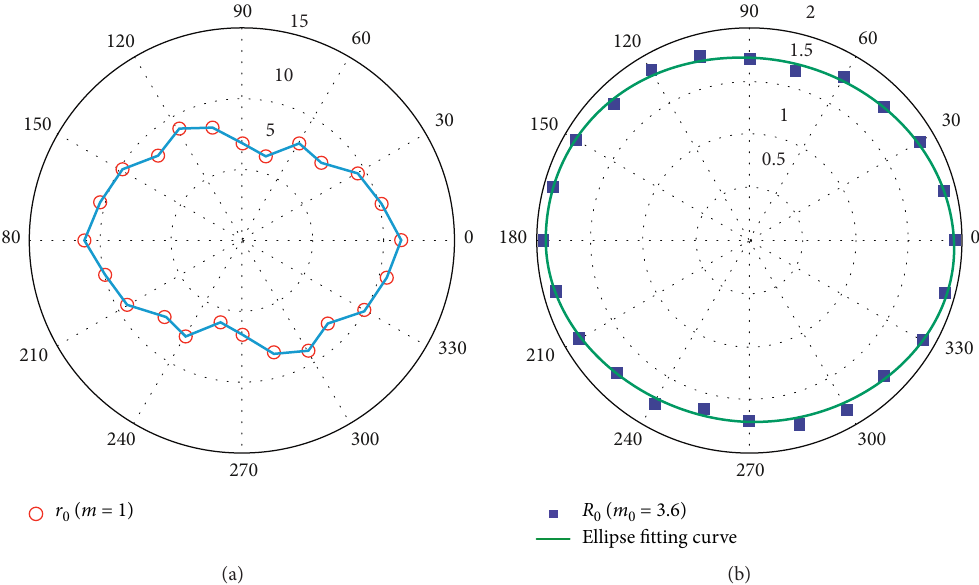
Figure 6: Polar plots of the original and processed JRC values and the ellipse fitting curves of the test samples in the length of 200mm.